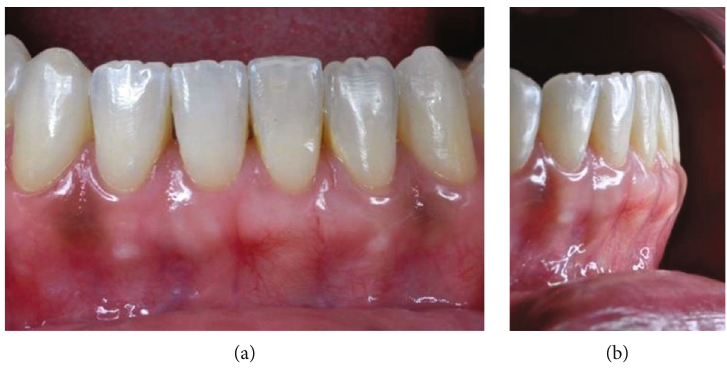
Figure 16: (a, b) One year